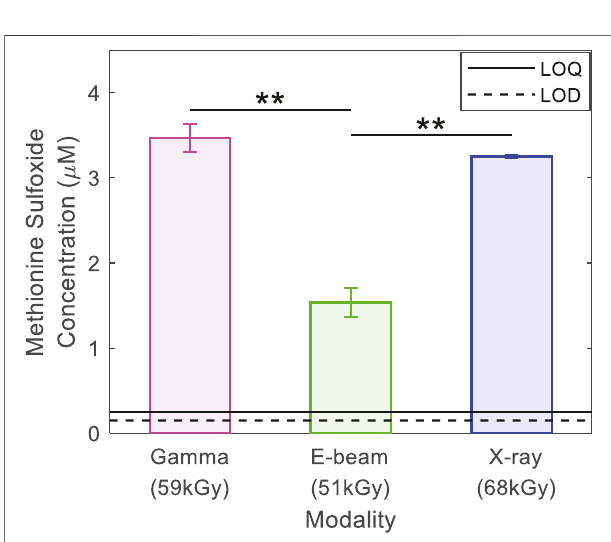
FIGURE 5 | Methionine sulfoxide concentration (µM) in stored solution for 10 days in series #1 bags and analyzed by HPLC. Irradiation doses were 59 kGy for gamma irradiation, 51 kGy for e-beam and 68 kGy for X-rays. The solid line indicates the Limit of Quanti fi cation (LOQ), and the dashed line indicates the Limit of Detection (LOD). ** means that the difference is statistically signi fi cant, and p -value < 1%.